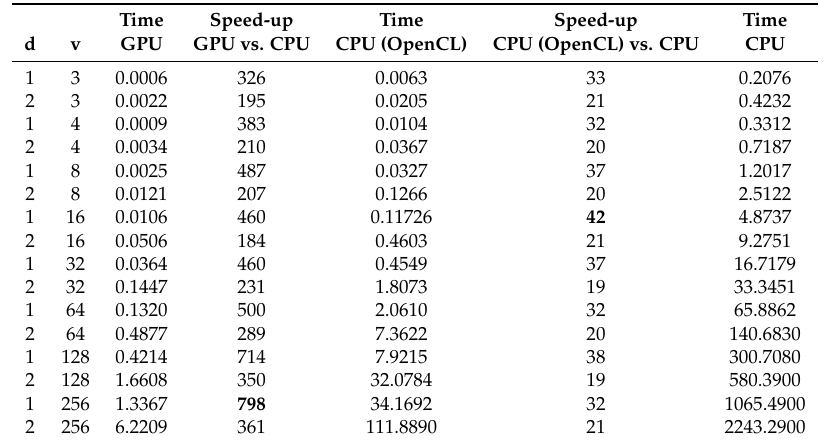
Table 2. Performance of the NLM algorithm applied to any band of the Ajka image (size 400 × 256) for different values of the similarity ( d , column 1) and search ( v , column 2) windows. Computational time of the portable OpenCL code run on GPU and CPU platforms is shown in columns 3 and 5, respectively. Moreover, column 7 reports the computational time of the sequential algorithm for the CPU. The speed-up of the portable parallel algorithm with respect to the sequential one run on the GPU and on the CPU is also shown in columns 4 and 6, respectively. Cases with the highest speed-up are highlighted in boldface.